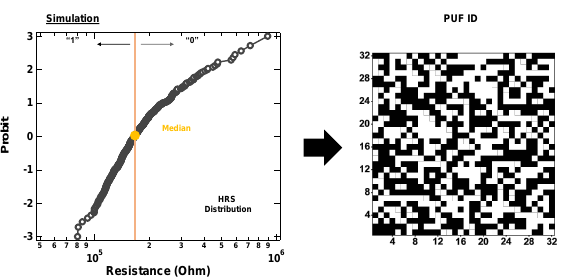
Figure 4: The PUF implementation method using the HRS variation. The threshold value is defined by the median resistance (150 kOhm). The right hand figure show schematically an example of binarized PUF data resulting from the resistance comparison.